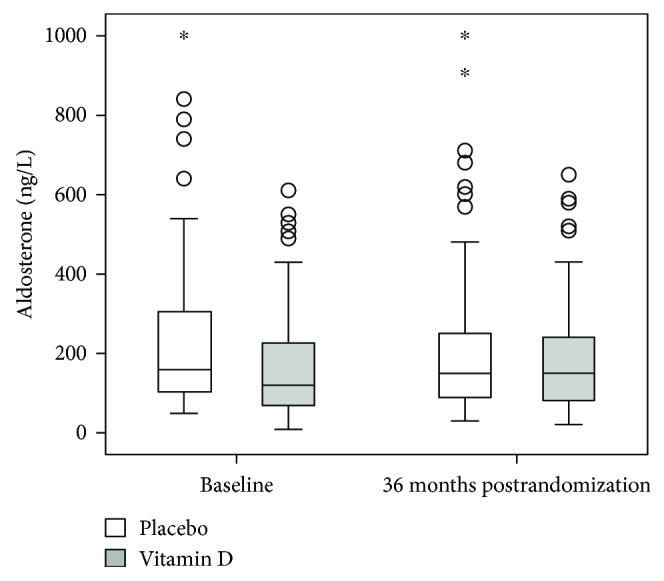
Plasma concentrations of aldosterone are illustrated at baseline and study termination. The boxes express the upper and lower quartiles, and the central lines show the median. Whiskers indicate the 5%–95% range, circles designate outliers, and stars denote extremes. Statistical analyses are presented in the Results section.